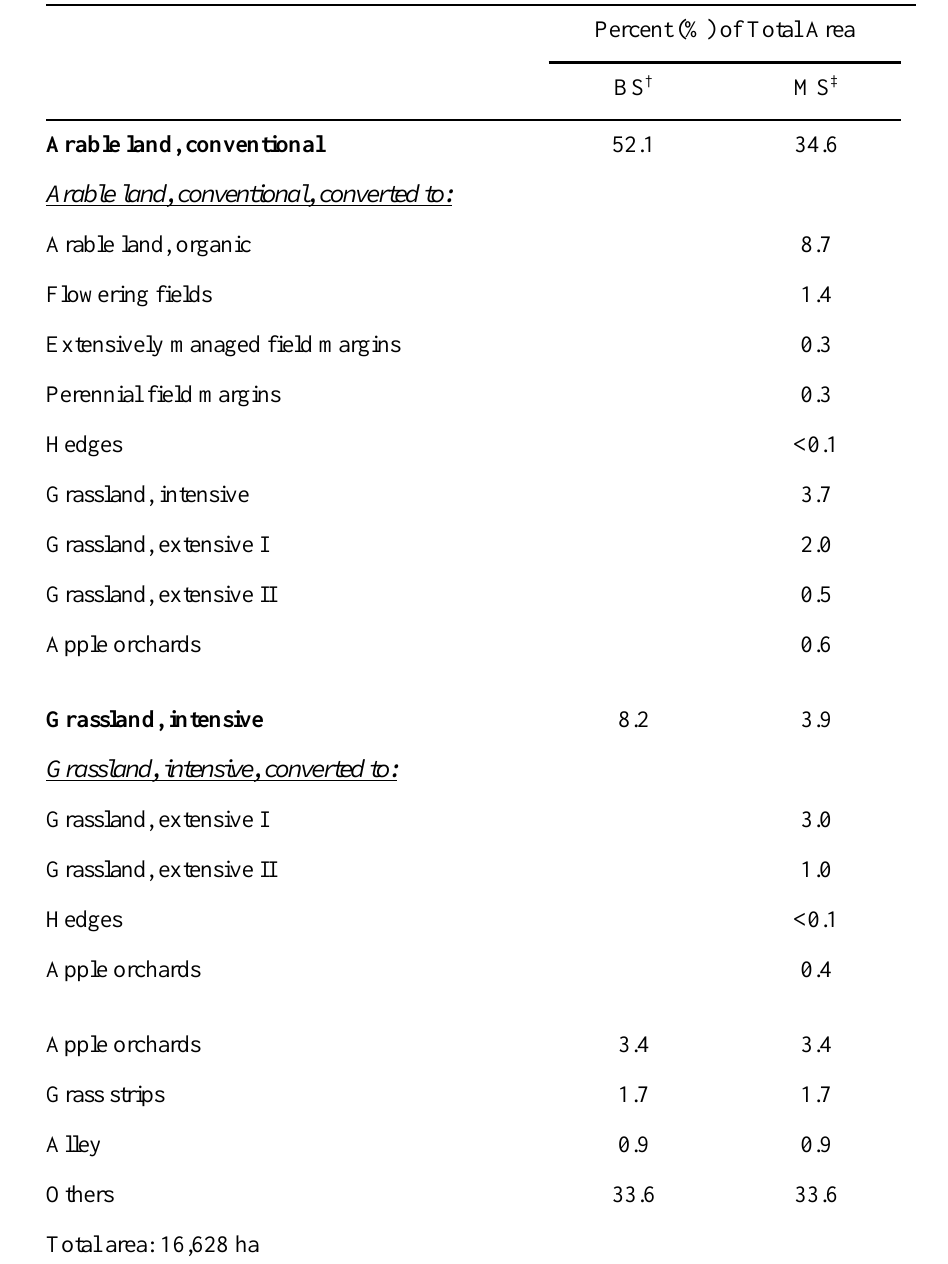
Table 3 . Proportions of land uses in the BS and the